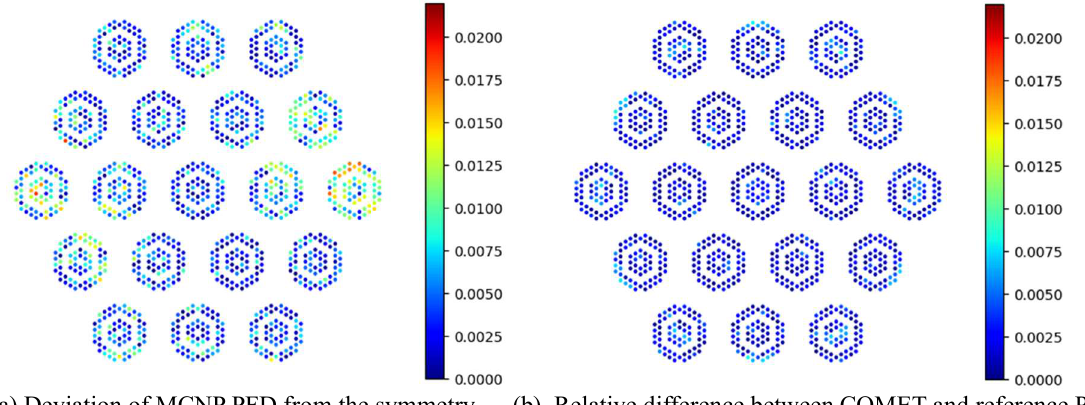
Figure 6. Comparison of the PDF distribution for the CRT